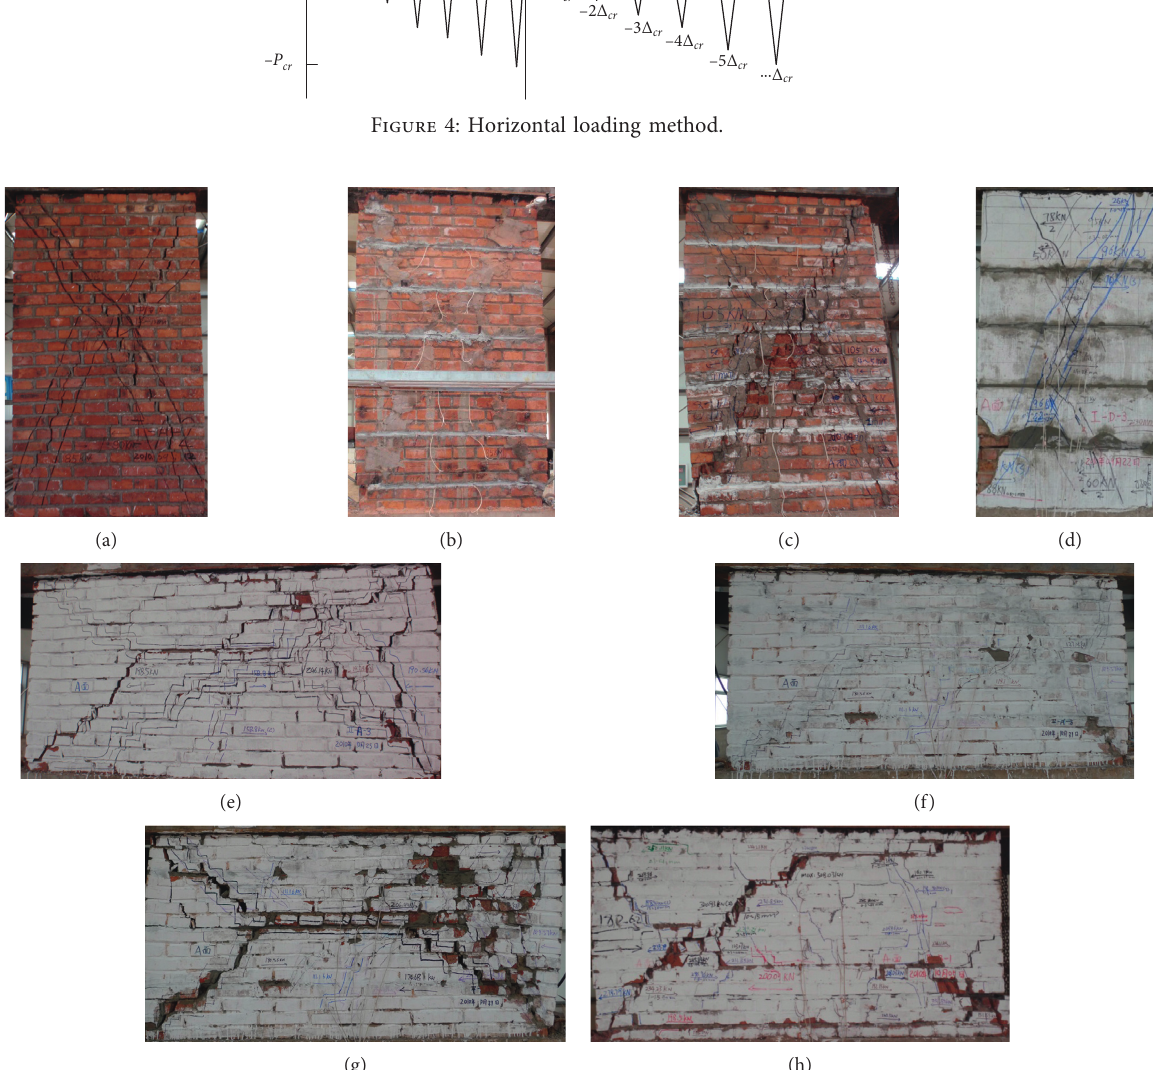
Figure 5: Failure modes of specimens. (a) Developing of cracks in Q1. (b) Morphology of Q1 after repairing (JQ1). (c) Developing of cracks in JQ1. (d) Developing of cracks in QA1. (e) Developing of cracks in Q2. (f) Morphology of Q2 after repairing (JQ2). (g) Developing of cracks in JQ2. (h) Developing of cracks in